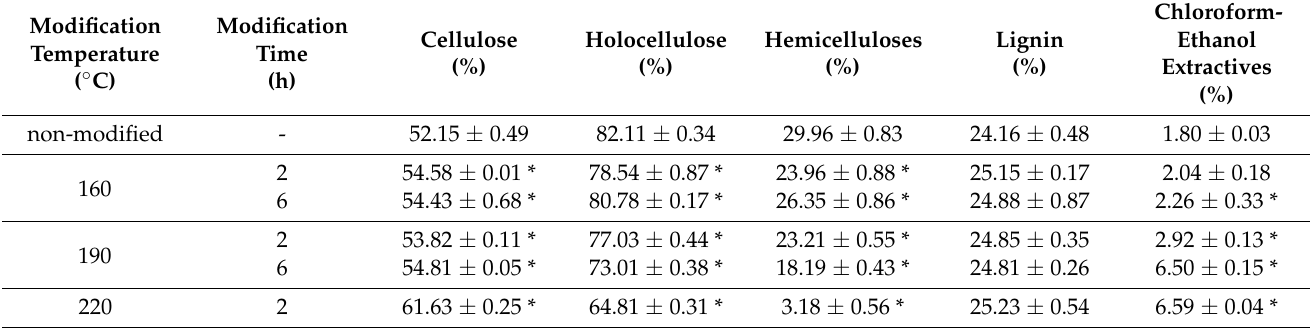
Table 2. Chemical composition of black poplar: non-modified and thermally modified in nitrogen atmosphere; ± (SD).